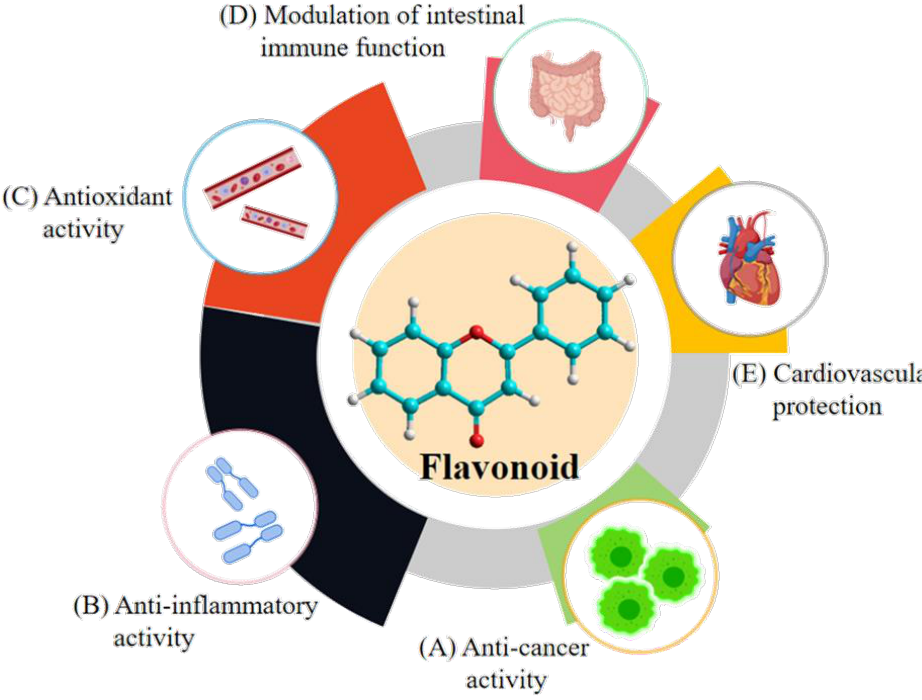
Figure 2. Pharmacological activities of flavonoids.